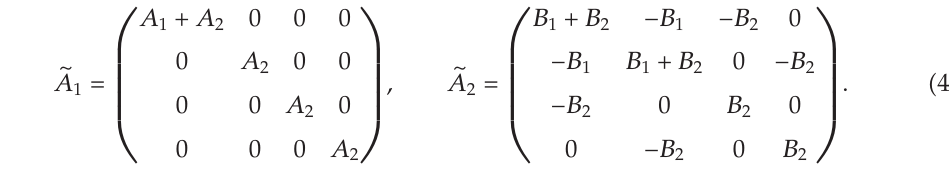
Algorithm 4.2. We divide our time interval (cid:4) 0 , T (cid:5) into subintervals (cid:4) t n , t n (cid:8) 1 (cid:5) , where n